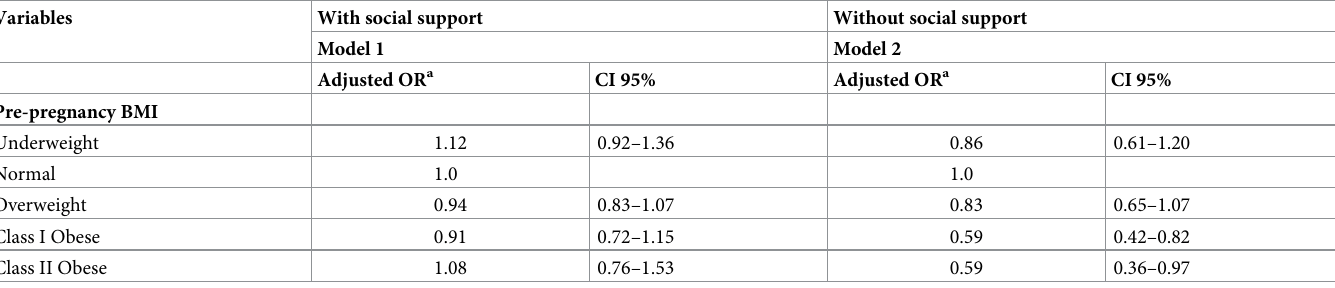
Table 3. Final adjusted models for the association between pre-pregnancy BMI and breastfeeding in the first hour after birth by social support status, Brazil, 2011.